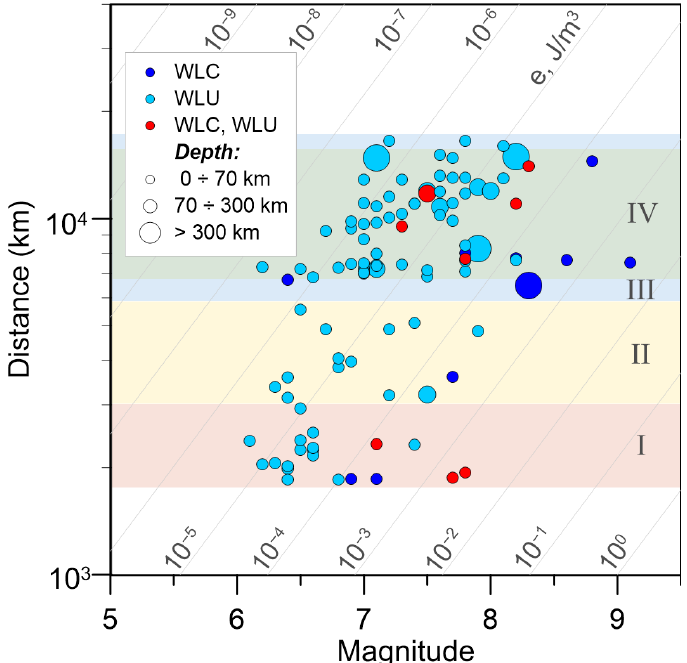
Figure 10. Hydrogeologycal responses recorded at the Mikhnevo observatory to the passage of seismic waves from distant earthquakes: only in WLC (deep blue signs), only in WLU (light blue circles), both in WLC and WLU aquifers (red signs). Circle size corresponds to the different depth of the earthquakes. Grey lines correspond to constant seismic energy density e . Seismic belts: I—Mediterranean, II—Trans ‐ Asian, III—West Pacific, IV—East Pacific.